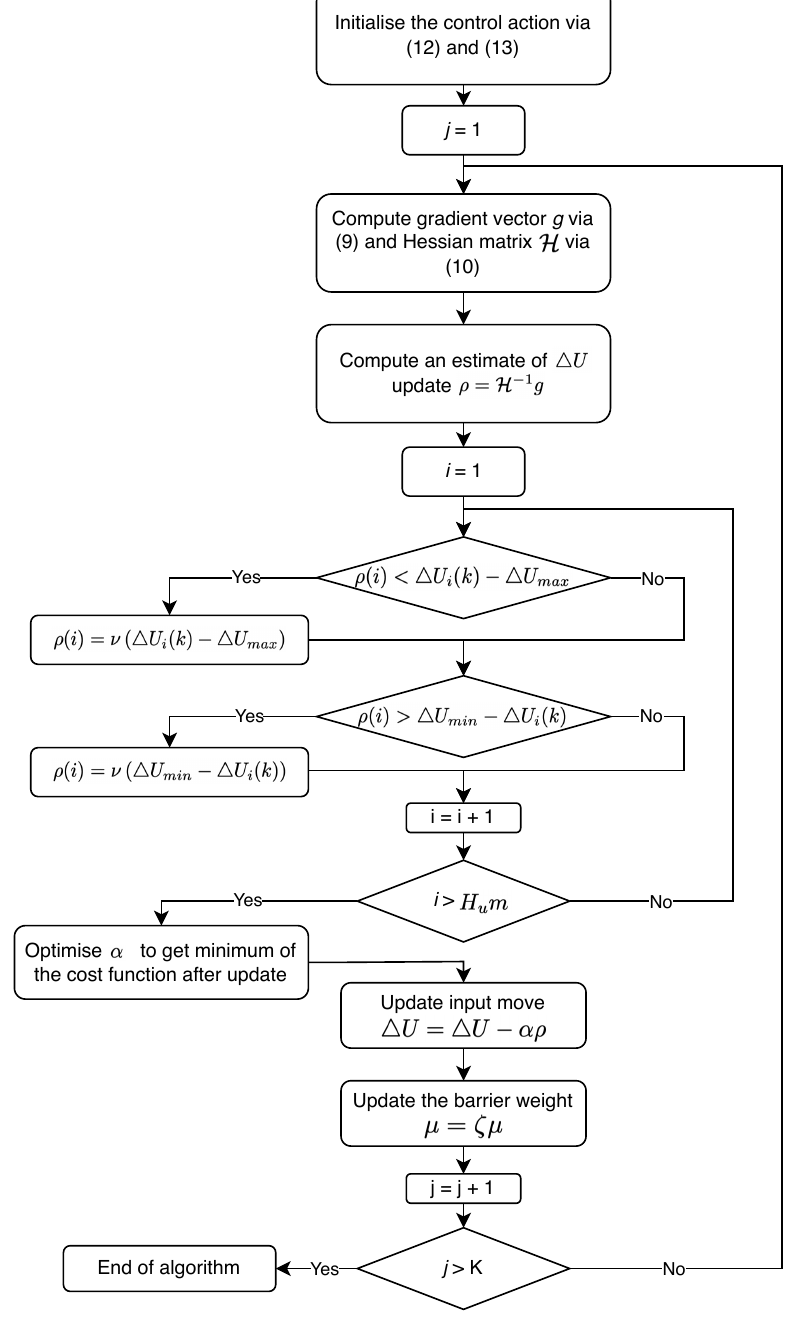
Figure 2. An algorithm for the implementation of constrained model predictive